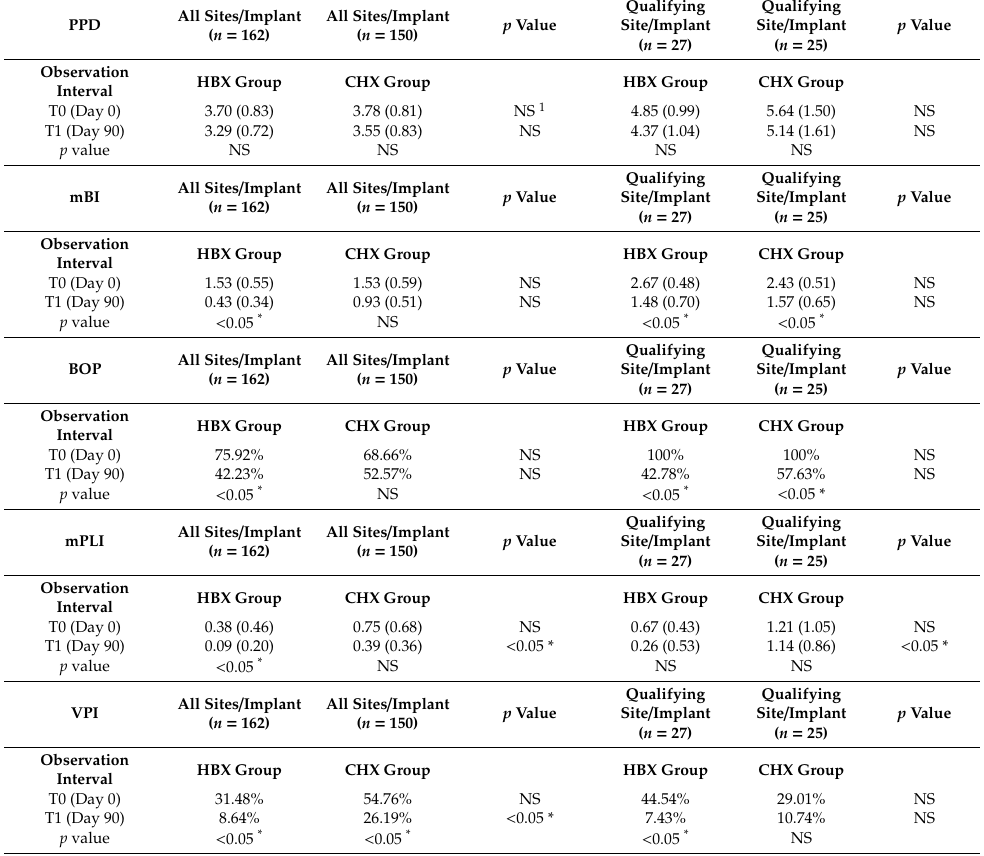
Table 2. Soft tissues assessment for Test-Group (HBX) and Control-Group (CHX) throughout the three-month observation interval (from T0 to T1), at all six sites / implant (HBX-Group, n = 162; CHX-Group, n = 150) and at the Qualifying site / implant (HBX-Group, n = 27; CHX-Group, n =